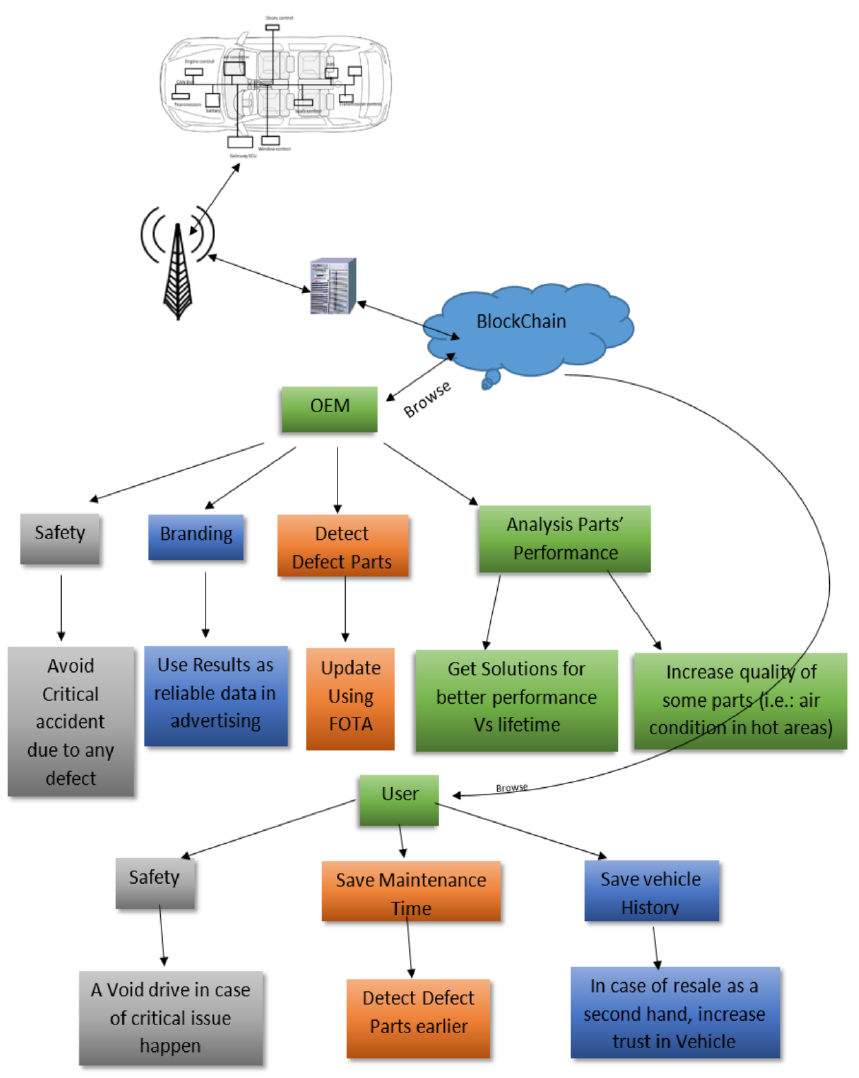
Figure 13. The main benefits from the user and OEM’s point of